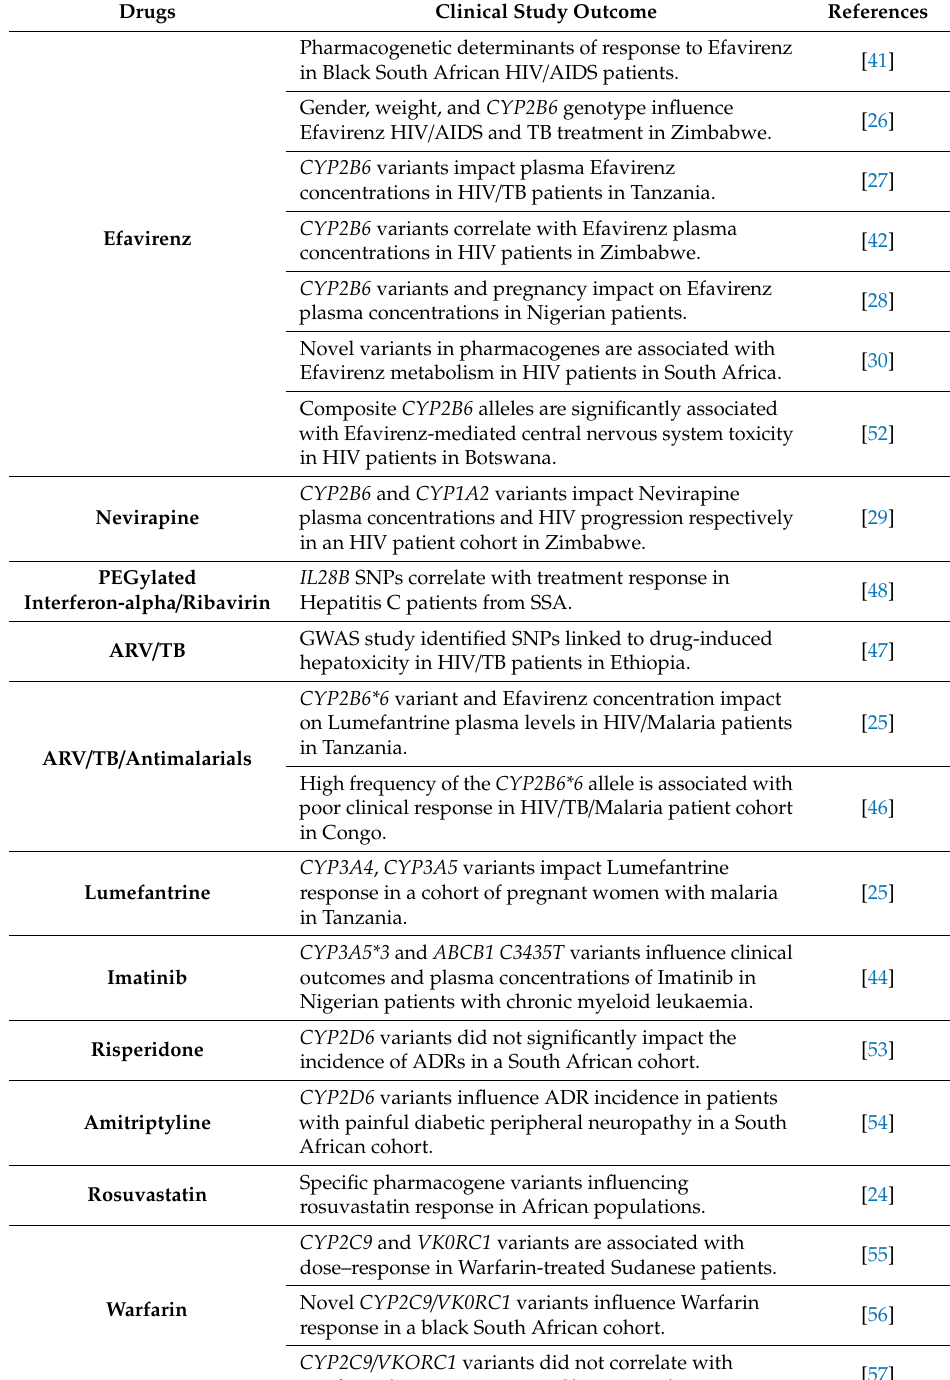
Table 1. Clinical studies aimed at validating pharmacogenetic biomarkers on clinical outcomes on sub-Saharan African